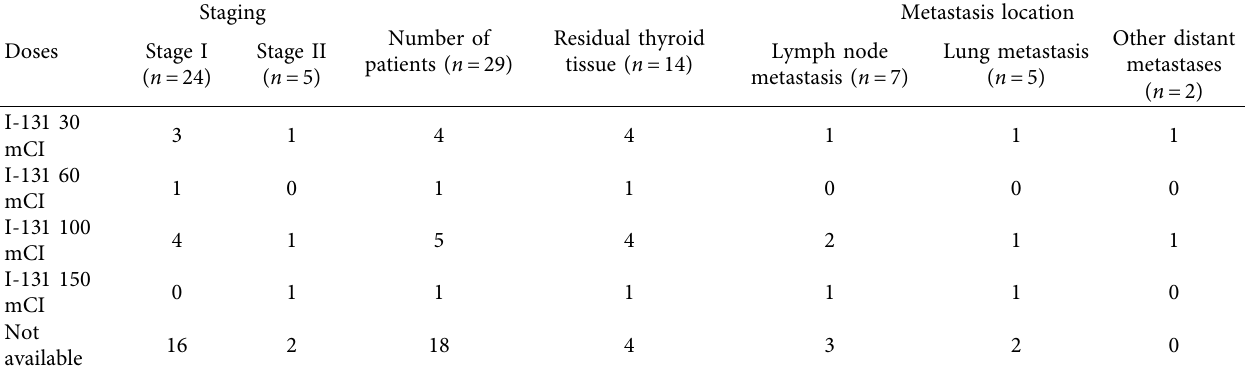
Table 5: Radioactive iodine therapy’s doses.